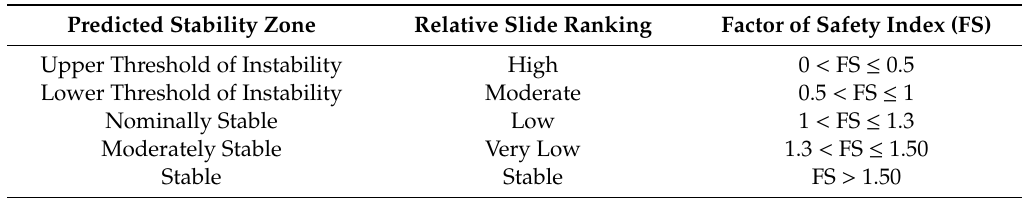
Table 1. FS value classes in the map.